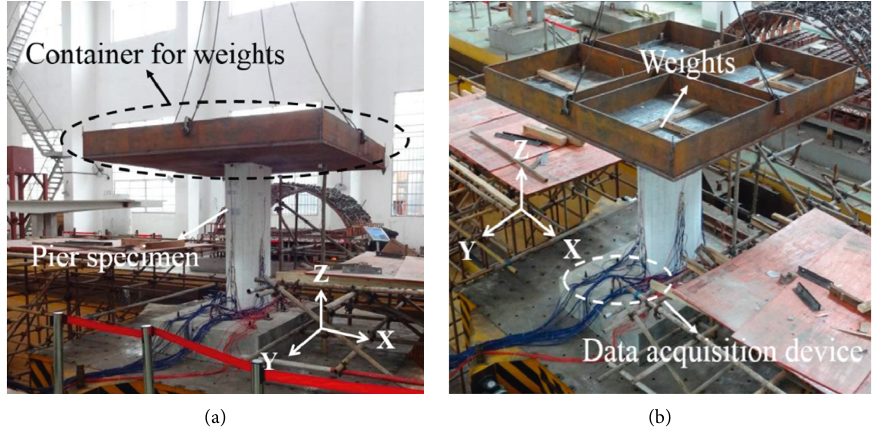
Figure 2: Assembled experimental pier